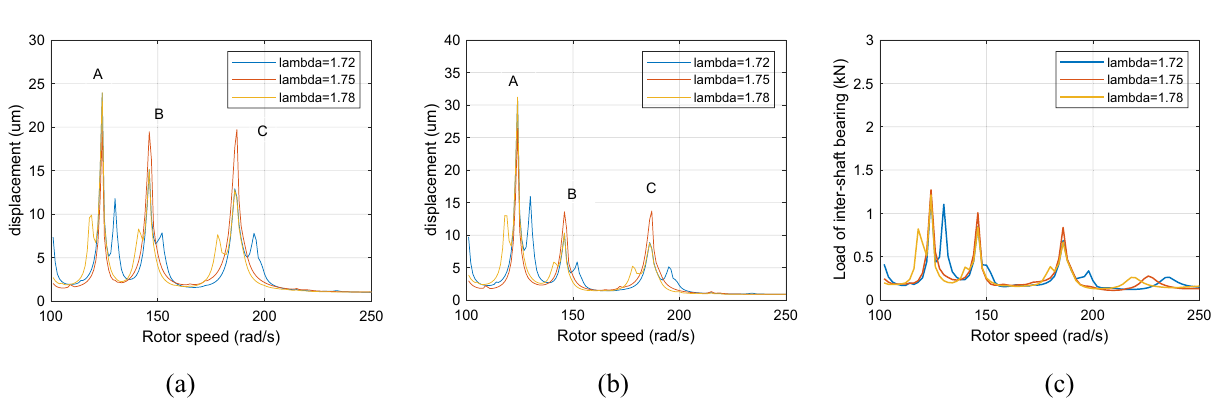
Figure 11. Partial enlarged view of Fig. 9 (λ = 1. 72, 1. 75, 1. 78, F 0 = 100, A max = 200) ( a ) LP rotor ( b ) HP rotor ( c ) inter-shaft bearing’s